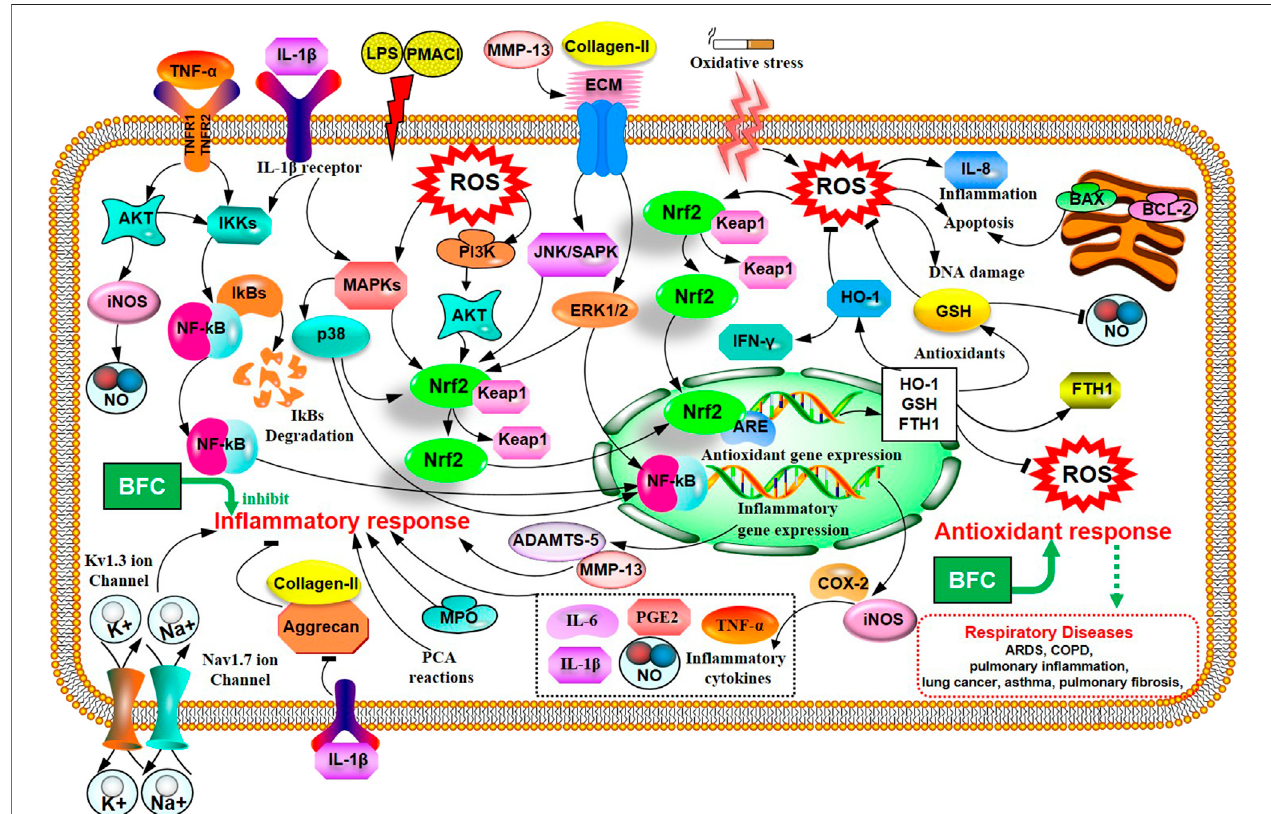
FIGURE 2 | The anti-in fl ammatory and anti-oxidative stress signaling pathways of BFC.